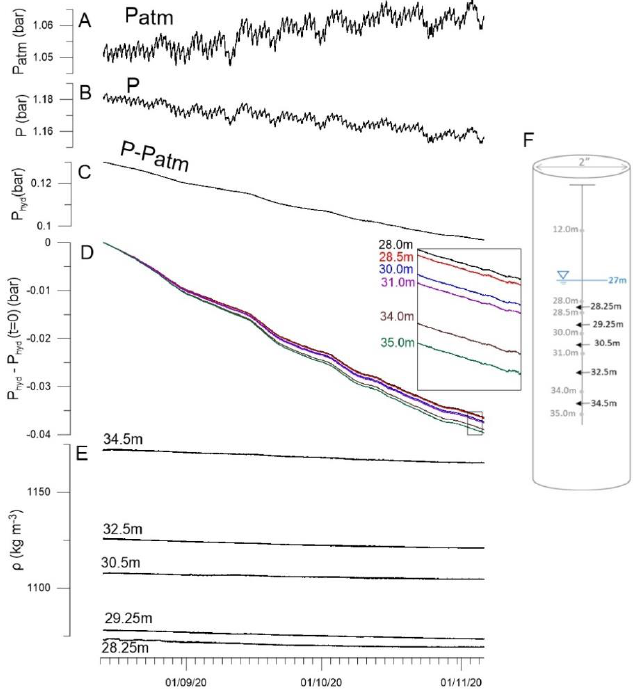
Figure 6. Temporal variations of the vertical properties at the coastal aquifer. ( A ) Atmospheric pressure. ( B ) Water pressure (Equation (1)) of 28 m sensor. ( C ) Hydrostatic pressure (Equation (3)) at the 28 m sensor (assuming negligible dynamic pressure). ( D ) Hydrostatic pressure at all depths, relative to initial values (P hyd − P hyd (t = 0)). The insert includes the depth of the sensors. ( E ) Density variation with time at different depths based on the hydrostatic densitometer (Equation (6)). ( F ) Schematic illustration of the hydrostatic densitometer in the EG26 borehole (see Section 4. 3 for more details).